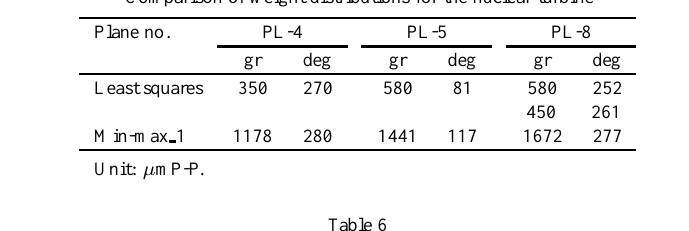
Table 6 Rotor vibration from min-max 2 with the response constraint for the nuclear turbine Probe